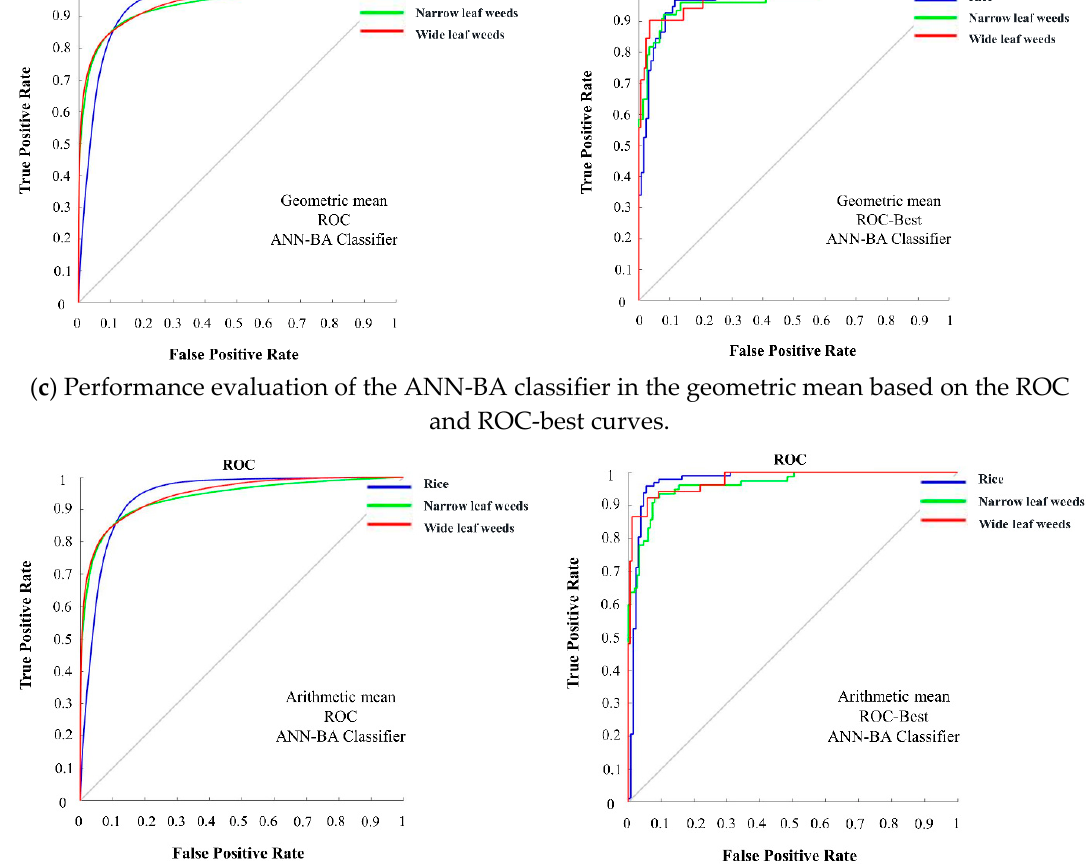
Table 8. Mean area under the receiver operating characteristic (ROC) curves (AUC) for the hybrid ANN-BA classifier for rice, narrow-leaf weed, and wide-leaf weed classes: right channel, left channel, arithmetic mean, and geometric